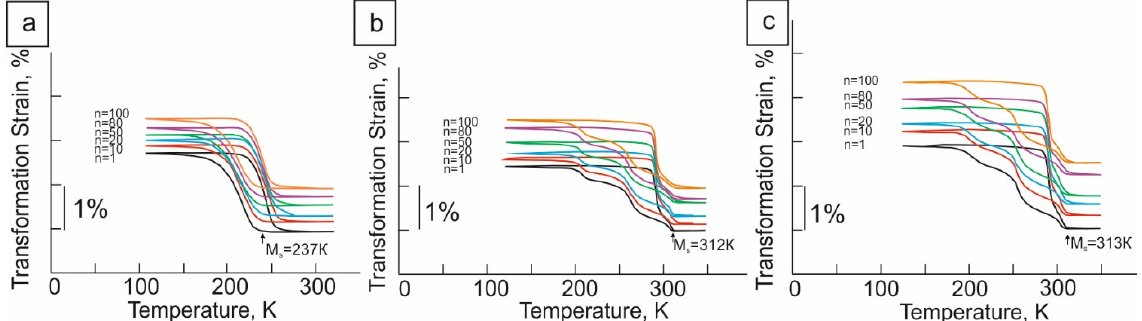
Figure 4. Cyclic stability of SME under compressive stress 100 MPa at the number of repeating cycles from 1 to 100 of the [011]-oriented Ti-50.1Ni single crystals: ( a )—quenching; ( b )—annealing at 713 K for 0.5 h in helium gas; ( c )—annealing at 713 K for 0.5 h in dry air.